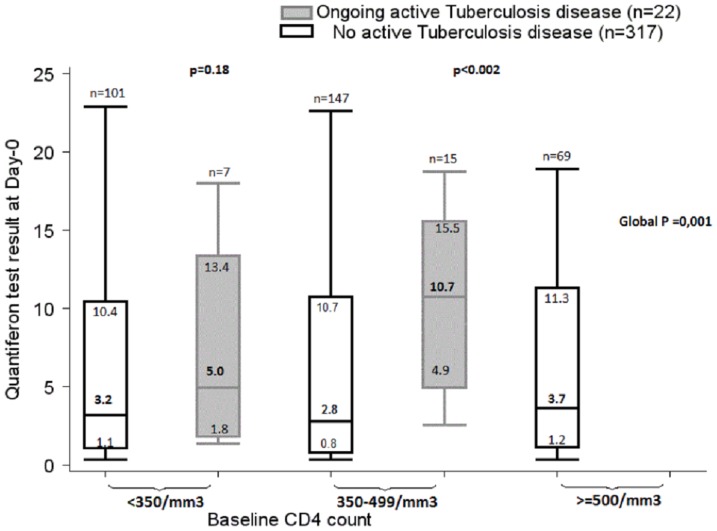
Distribution of QuantiFERON TB Gold in-tube test results at Day-0, by CD4 count category in patients with positive tests and with or without active tuberculosis.Box plots show median value, interquartile range, and range. p: Kruskal-Wallis test.